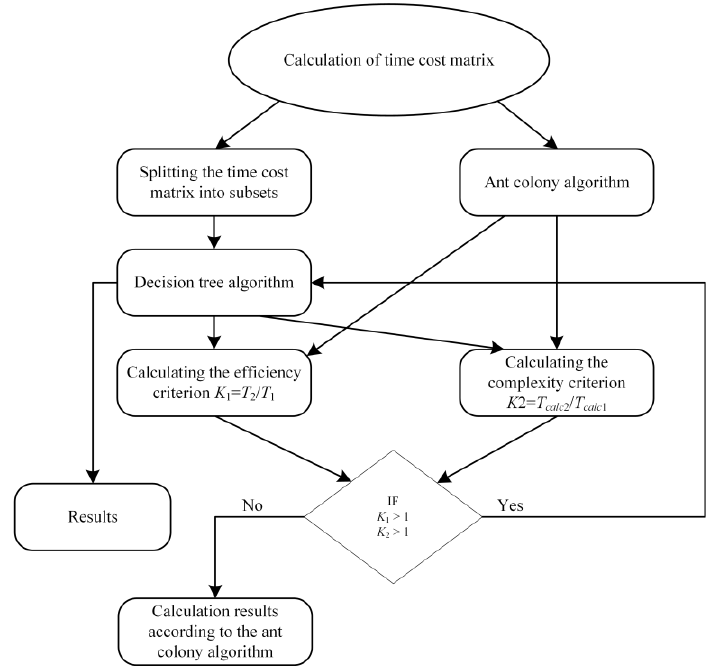
Fig. 3. The algorithm of time cost matrix